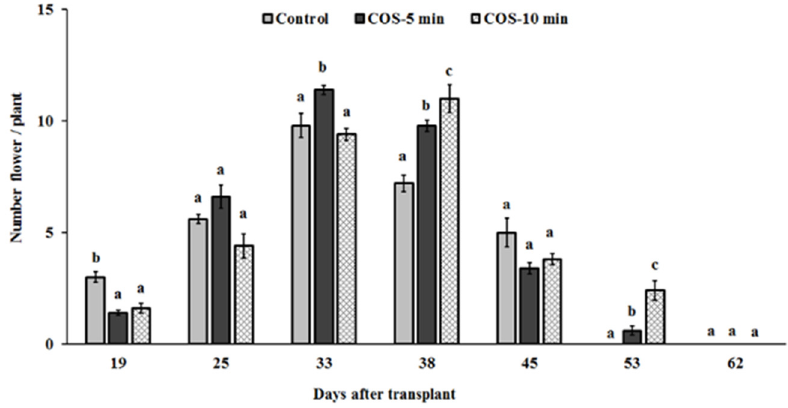
Figure 4. The effect of the EBP-produced COS on flower number in tomato plants (cv. Micro-Tom). Treatments were applied three times after transplanting by foliar spray at 0.25 mg/mL (1, 25, and 37 days, respectively). The data are presented as Means ± SE. The same letters within the same time point indicate that there are no statistically significant differences between the data. For example, for day 33, a statistically significant increase ( p ≤ 0.05, Fisher’s LSD test) is observed only for COS-5 min (marked as b ), and for control and COS-10 (marked as a ) there are no statistically significant differences.